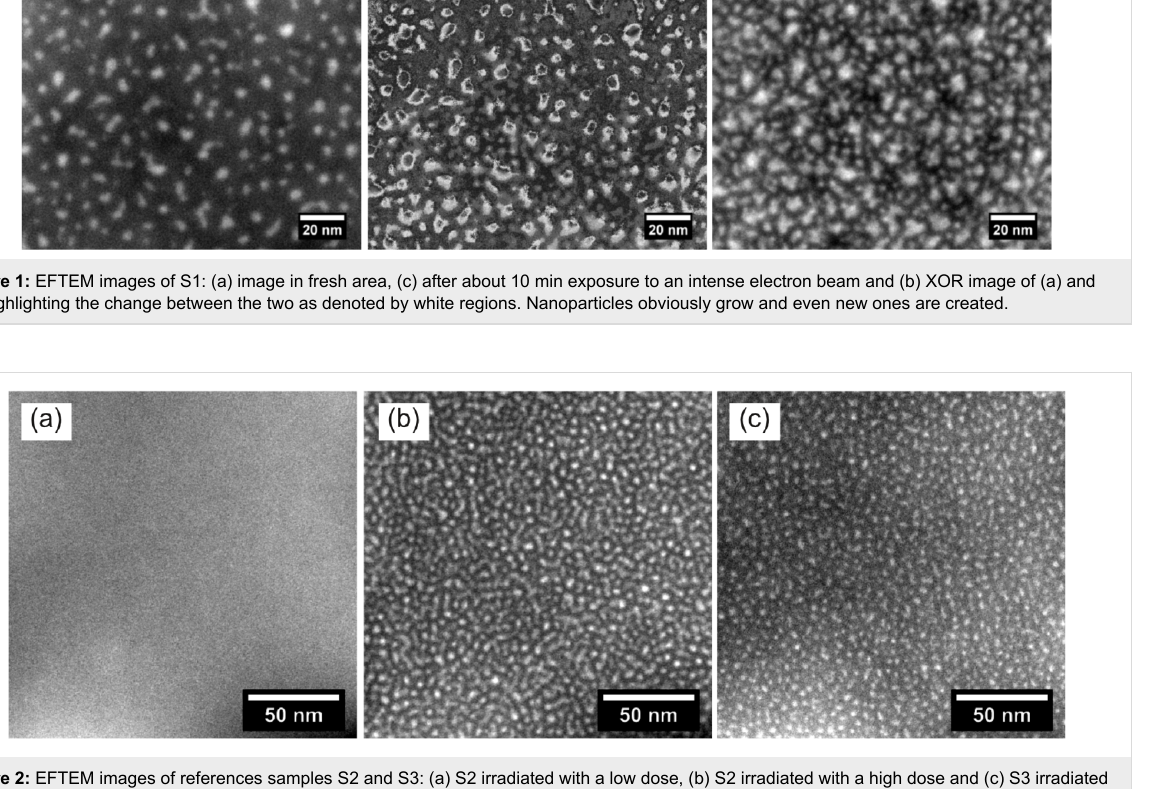
Figure 2: EFTEM images of references samples S2 and S3: (a) S2 irradiated with a low dose, (b) S2 irradiated with a high dose and (c) S3 irradiated with a high dose. After low dose irradiation no Si particles are observed (cf. panel (a)), whereas high doses lead to a dense formation of tiny Si nanoparticles (cf. panels (b) and